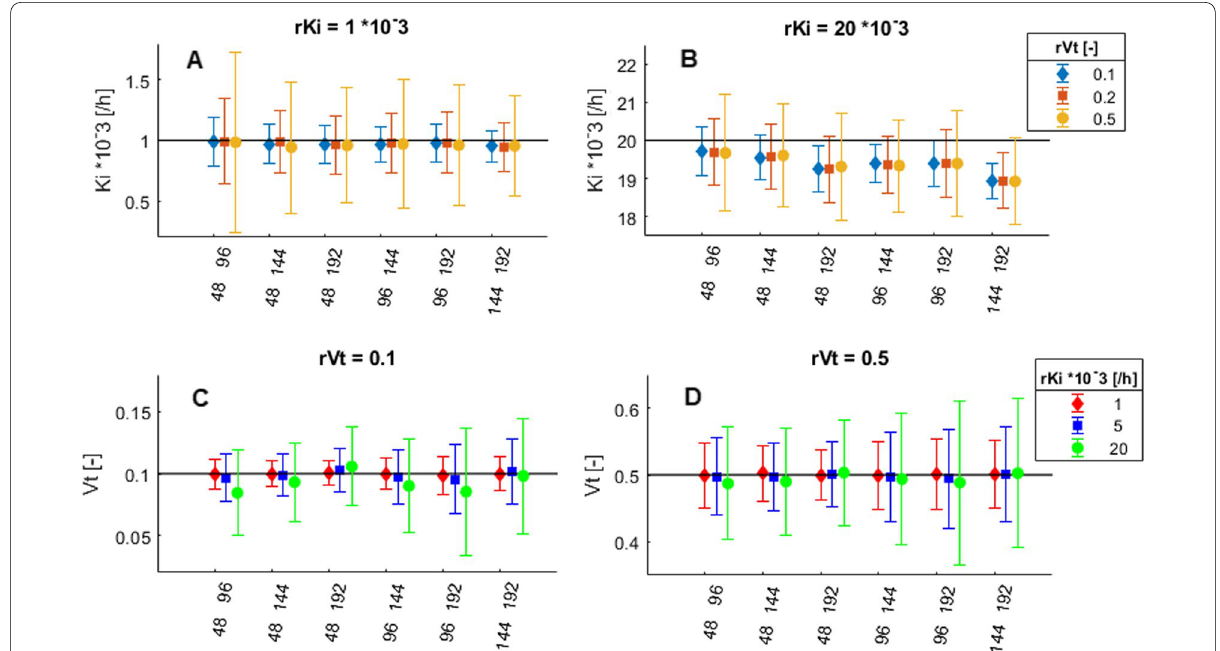
Fig. 4 Absolute K i ( A and B ) and V T ( C and D ) values per time point combination for rK i 89 Zr‑pertuzumab input function and time activity curves with 5% noise. All time point combinations on the x‑axis also included 24 h post‑injection.